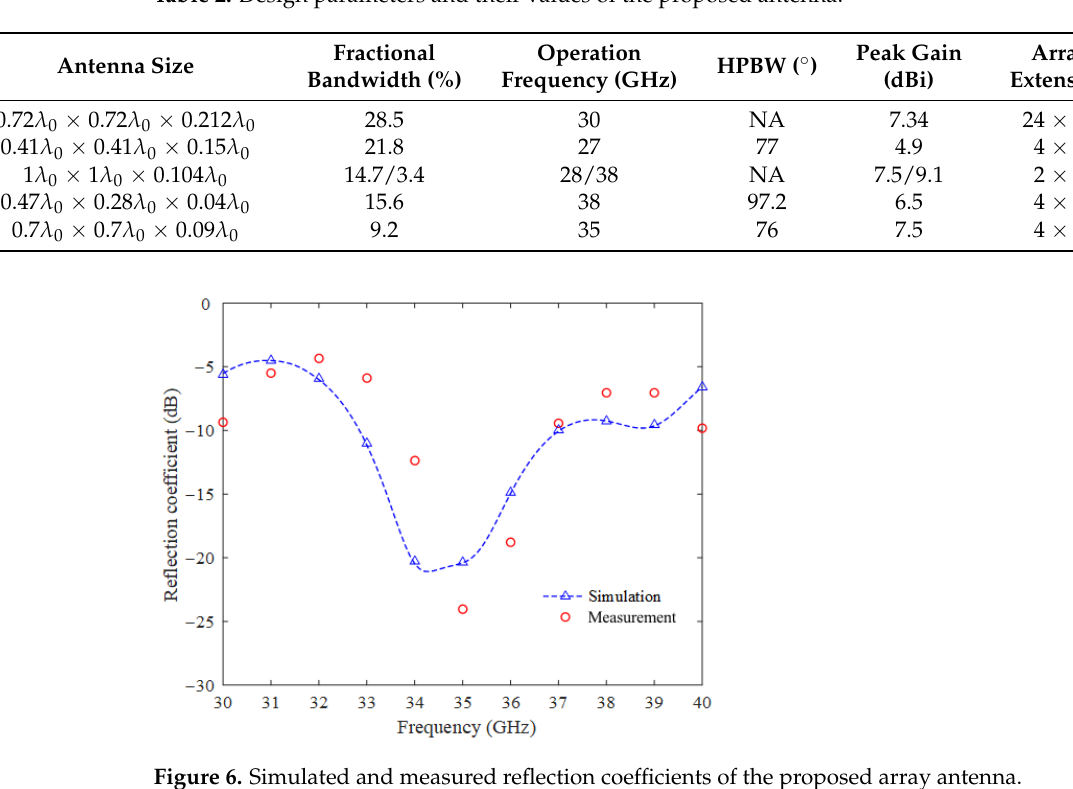
Table 2. Design parameters and their values of the proposed antenna.